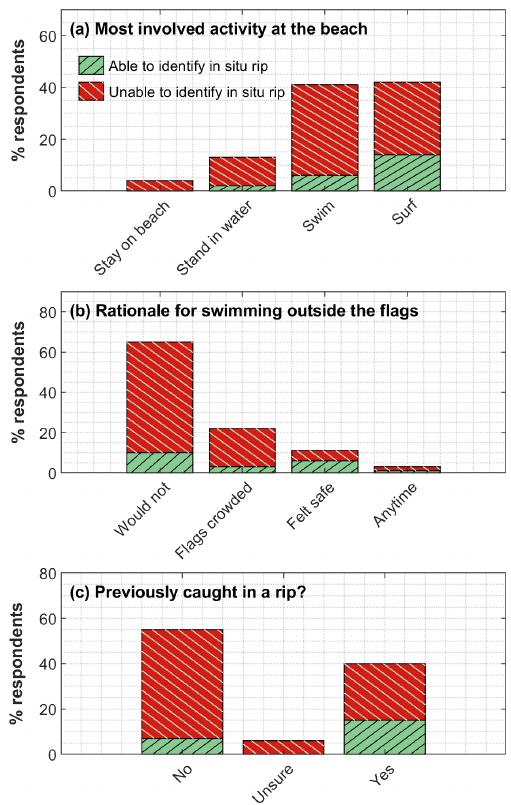
Figure 5. (a) Respondents’ activity at the beach, (b) rationale for swimming outside of the flagged bathing area, and (c) indication of those who have experience of being caught in a rip. Green bars are indicative of the number of respondents able to identify the in situ rip, and red bars are indicative of those who cannot.